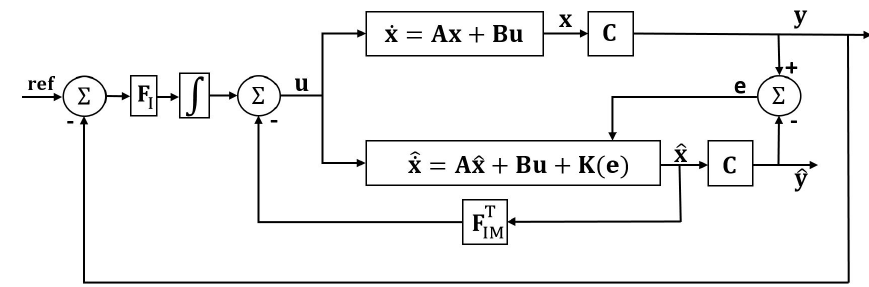
Figure 2. State feedback control scheme with observer for LMI-based